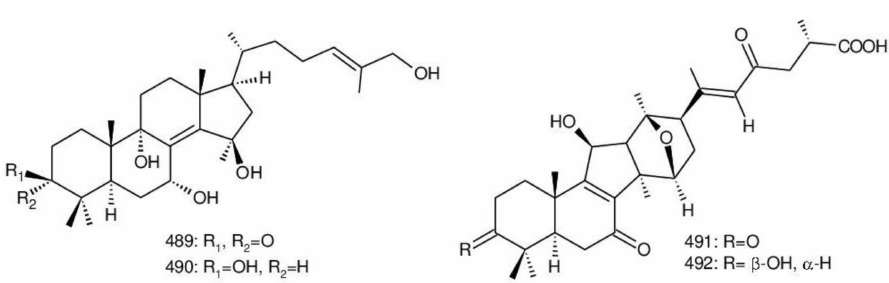
Figure 33. Chemical structures of several rearranged novel triterpenoids ( 489 – 492 ).